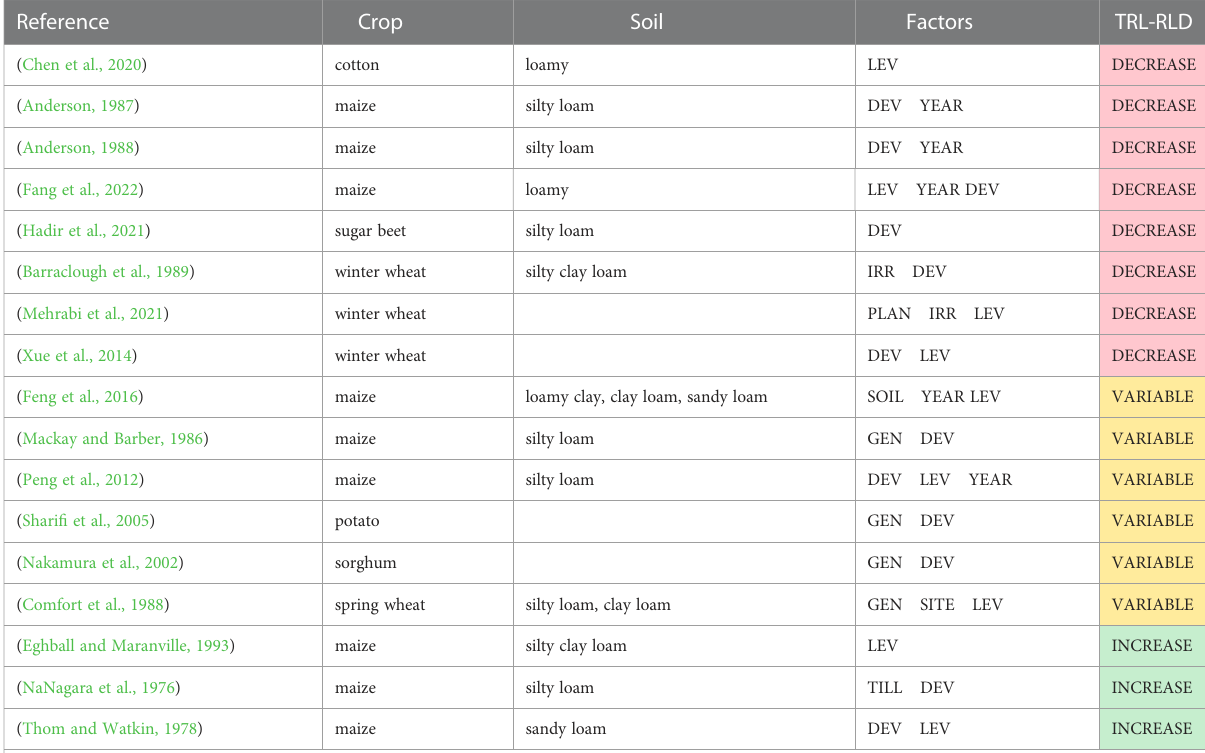
TABLE 2 Studies that report effects of N de fi ciency on total root length and/or root length density (TRL-RLD) at fi eld